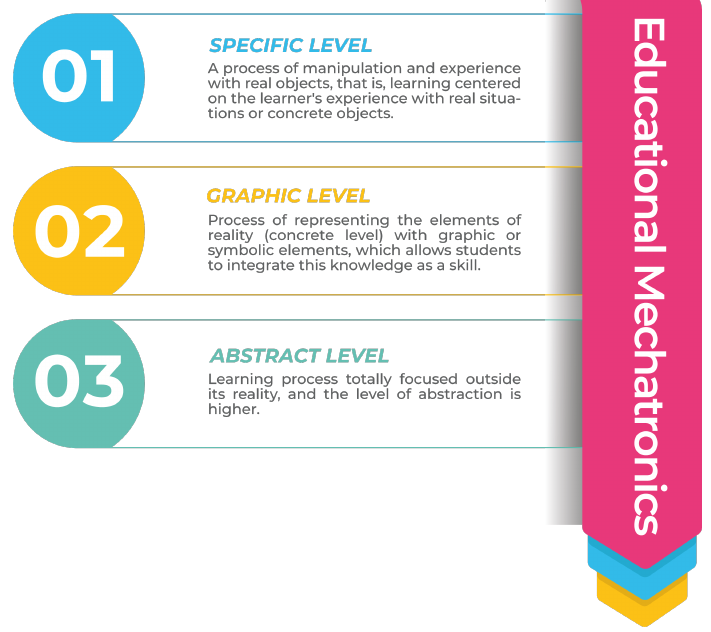
Figure 2. Levels of the learning